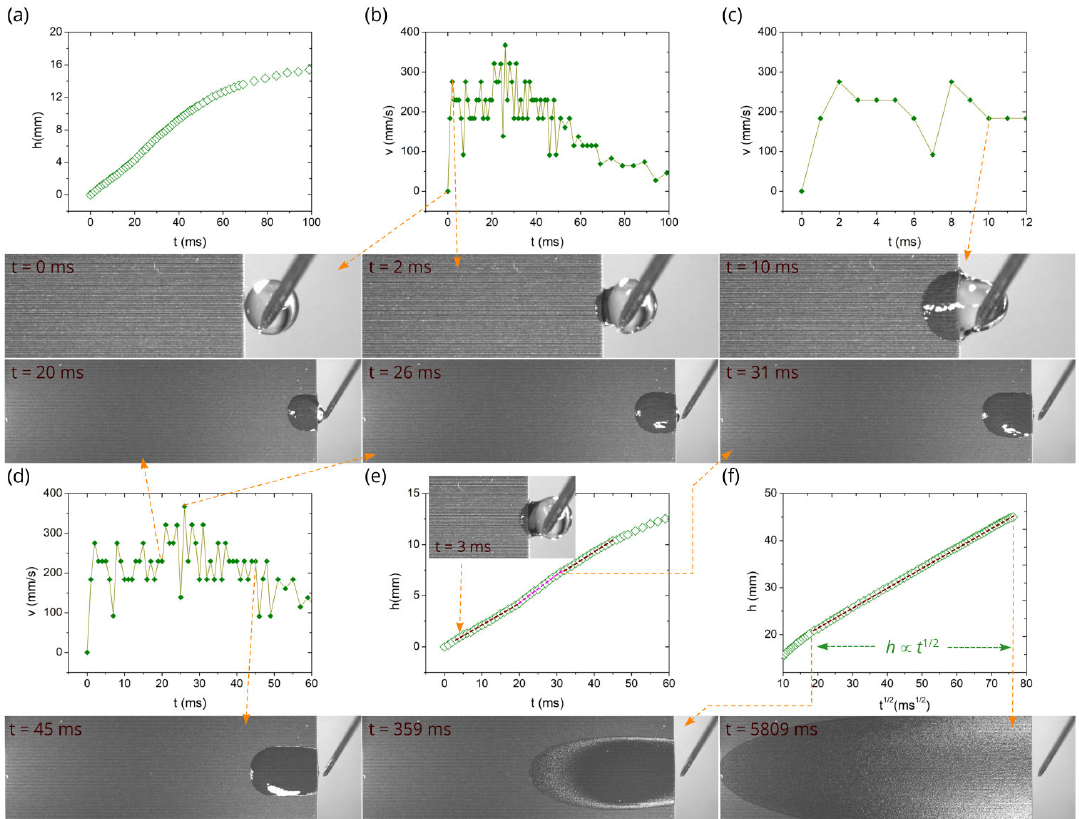
Figure 4. Detailed h ( t ) and v ( t ) plots along with snapshots of water spreading at room temperature. ( a ) Plot of the spreading distance as a function of time between 0 and 100 ms. ( b ) Plot of the velocity as a function of time. ( c ) Plot of the velocity as a function of time between 0 and 12 ms. ( d ) Plot of the velocity as a function of time between 0 and 60 ms. ( e ) Detailed plot of spreading distance as a function of time between 0 and 60 ms. ( f ) Plot of the spreading distance as a function of t 1 / 2